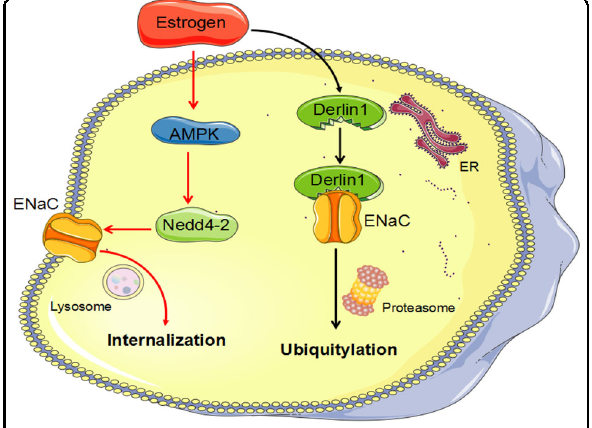
Fig. 10 Schematic diagram showing how estrogen downregulates ENaC by promoting derlin-1 expression and AMPK activation. Estrogen treatment decreased ENaC expression through two degradation pathways: in the fi rst, upregulation of derlin- 1 by estrogen promoted ENaC proteasome-related degradation, while in the second, activation of AMPK by estrogen induced ENaC internalization from the cell membrane and increased ENaC/Nedd4-2